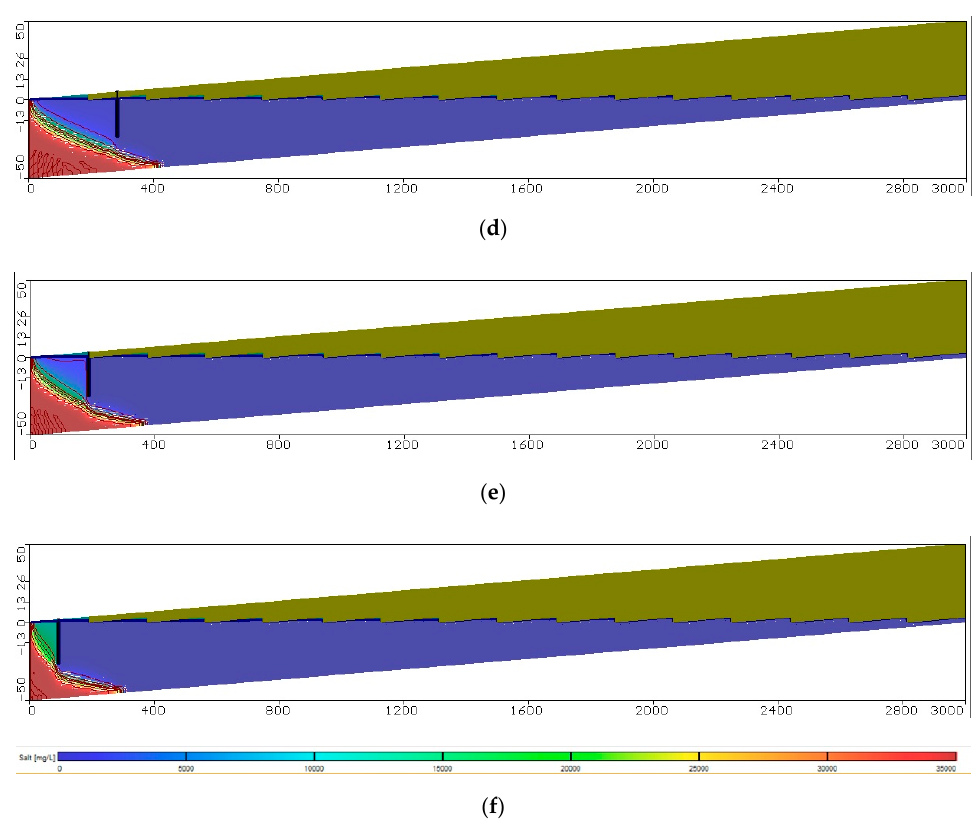
Figure A5. Saltwater distribution (in mg/L) in the Akrotiri aquifer for ( a ) the steady state and embedded barrier wall with d b /d = 0.5 and ( b ) X b /L o = 1.0, ( c ) X b /L o = 0.8, ( d ) X b /L o = 0.6, ( e ) X b /L o = 0.4 and ( f ) X b /L o = 0.2.